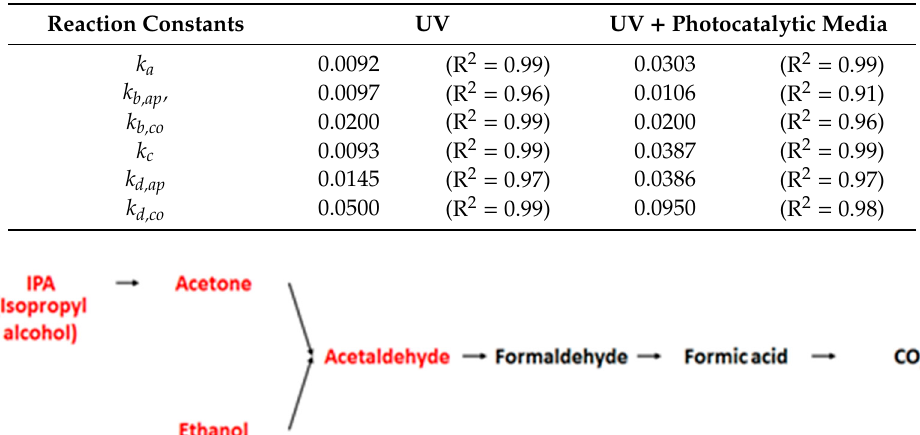
Table 2. Reaction constants of target compounds for decomposition by UV and UV + photocatalytic media.